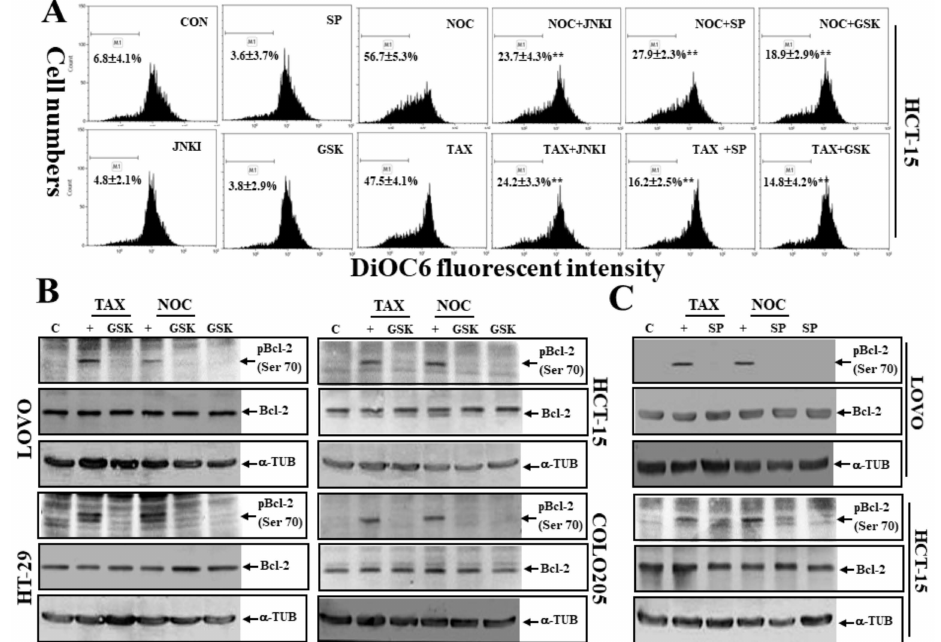
Figure 7. The PERK inhibitor GSK and the JNK inhibitors SP and JNKI inhibited TAX- and NOC-induced loss of the mitochondrial membrane potential (MMP) and phosphorylated B-cell lymphoma-2 (Bcl-2) (Ser-70) in human CRC cells. ( A ) HCT-15 cells were treated with GSK, SP, or JNKI (10 µ M) for 30 min, followed by TAX and NOC (10 µ M) stimulation for 12 h. The MMP was examined by a flow cytometric analysis via DiOC6 staining. ( B ) GSK inhibition of TAX- and NOC-induced phosphorylation of the Bcl-2 protein (pBcl-2) at Ser-70 in COLO205, HCT-15, HT-29, and LOVO cells. Cells were treated with GSK (10 µ M) for 30 min, followed by TAX or NOC stimulation for 12 h. ( C ) The JNK inhibitor SP decreased TAX- and NOC-induced phosphorylation of the Bcl-2 protein (pBcl-2) at Ser-70 in HCT-15 and LOVO cells. Both cell lines were treated with SP (10 µ M) for 30 min, followed by TAX or NOC stimulation for 12 h. Levels of Bcl-2, pBcl-2, and α -TUB proteins were examined by Western blotting using specific antibodies. Each data point was calculated from three triplicate groups, and data are displayed as the mean ± SD. ** p < 0.01 denotes a significant di ff erence from NOC- and TAX-treated groups,